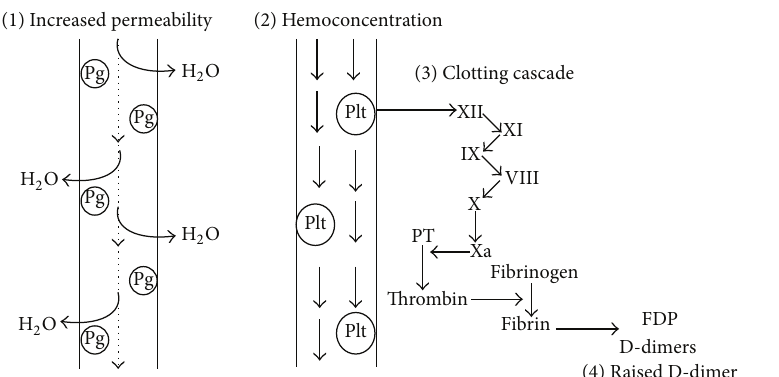
Figure 1: Schematic illustration of how OHSS causes a rise in d-dimers. Pg = prostaglandin; Plt = platelets; FDP = fibrin degradation productions;PT=prothrombin.(1)Dottedarrowrepresentsnormalbloodflow.ProstaglandinsareincreasedinOHSSwhichcausesincreased capillary permeability. This forces water out of the capillaries and into the tissues. (2) Loss of water causes hemoconcentration of the blood which is represented by thick arrows. Due to this, activation of platelets occurs. (3) Activation of platelets causes activation of the clotting cascade (simplified without the activated factors). (4) The final products of the coagulation cascade are fibrin degradation products which can be measured in the blood as